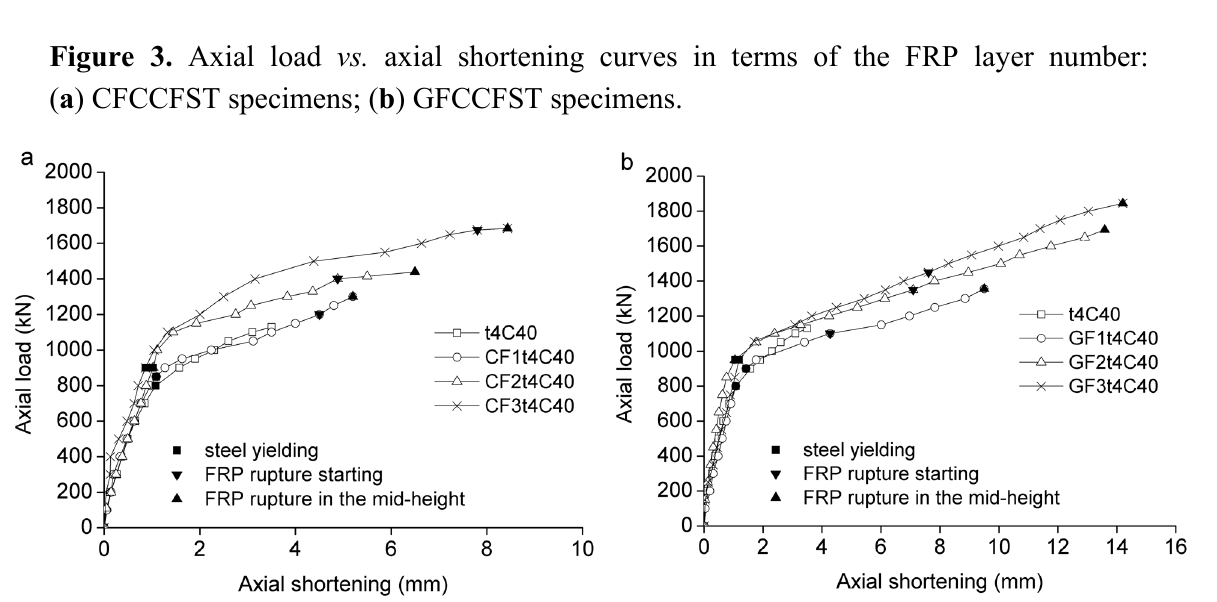
Figure 3. Axial load vs. axial shortening curves in terms of the FRP layer number: